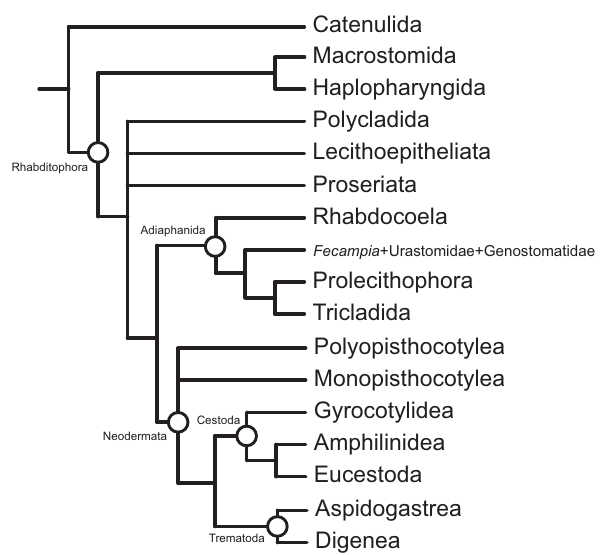
Fig 1. – Summary of major interrelationships amongst Platyhelmin- thes; drawn from various sources ( e.g . see Table